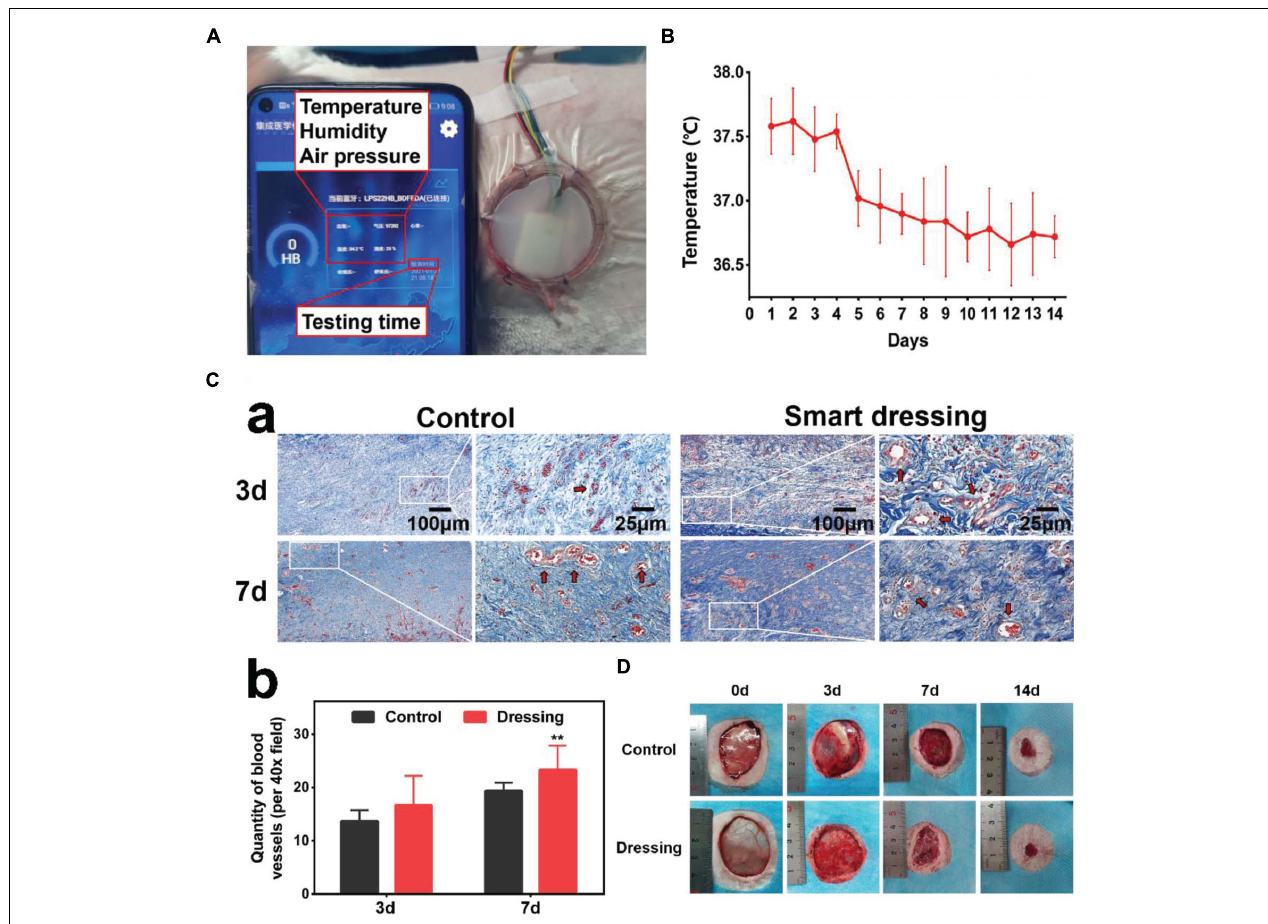
FIGURE 6 | In vivo application of the integrated smart dressing. (A) The integrated smart dressing enables the real-time monitoring of the microenvironment of wounds. (B) Characteristics of local temperature changes during wound healing recorded by the smart dressing. (C) Masson staining results of two groups of wound samples. (a) The wounds bandaged with smart dressings showed faster and higher quality neovascularization and a reduced inflammatory reaction than those in the control group (red arrow: neovascularization). (b) Quantitative analysis of neovascularization. (D) Images of the wound healing process. The wound healing of the integrated smart dressing was faster than that of the control. (** P < 0.05 was considered extremely